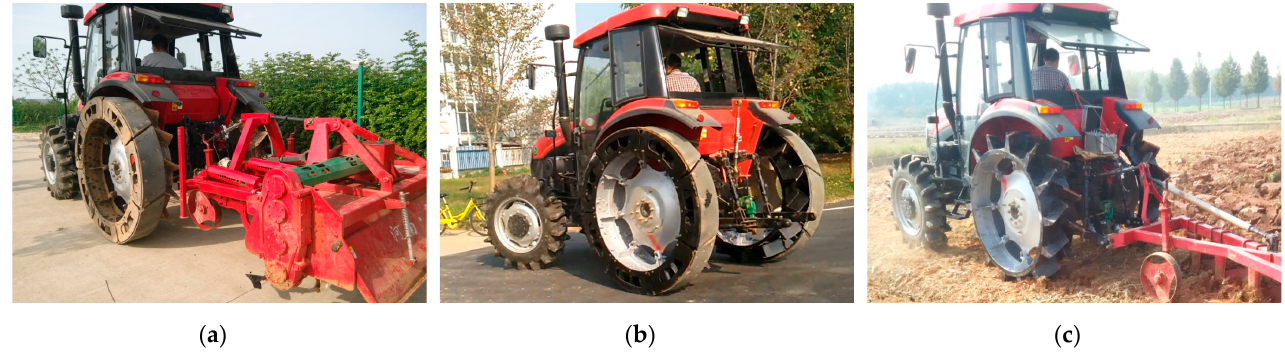
Figure 13. Rigid lugged wheel on-road drive tests, ( a ) concrete, ( b ) asphalt, and ( c ) field drive and traction test.